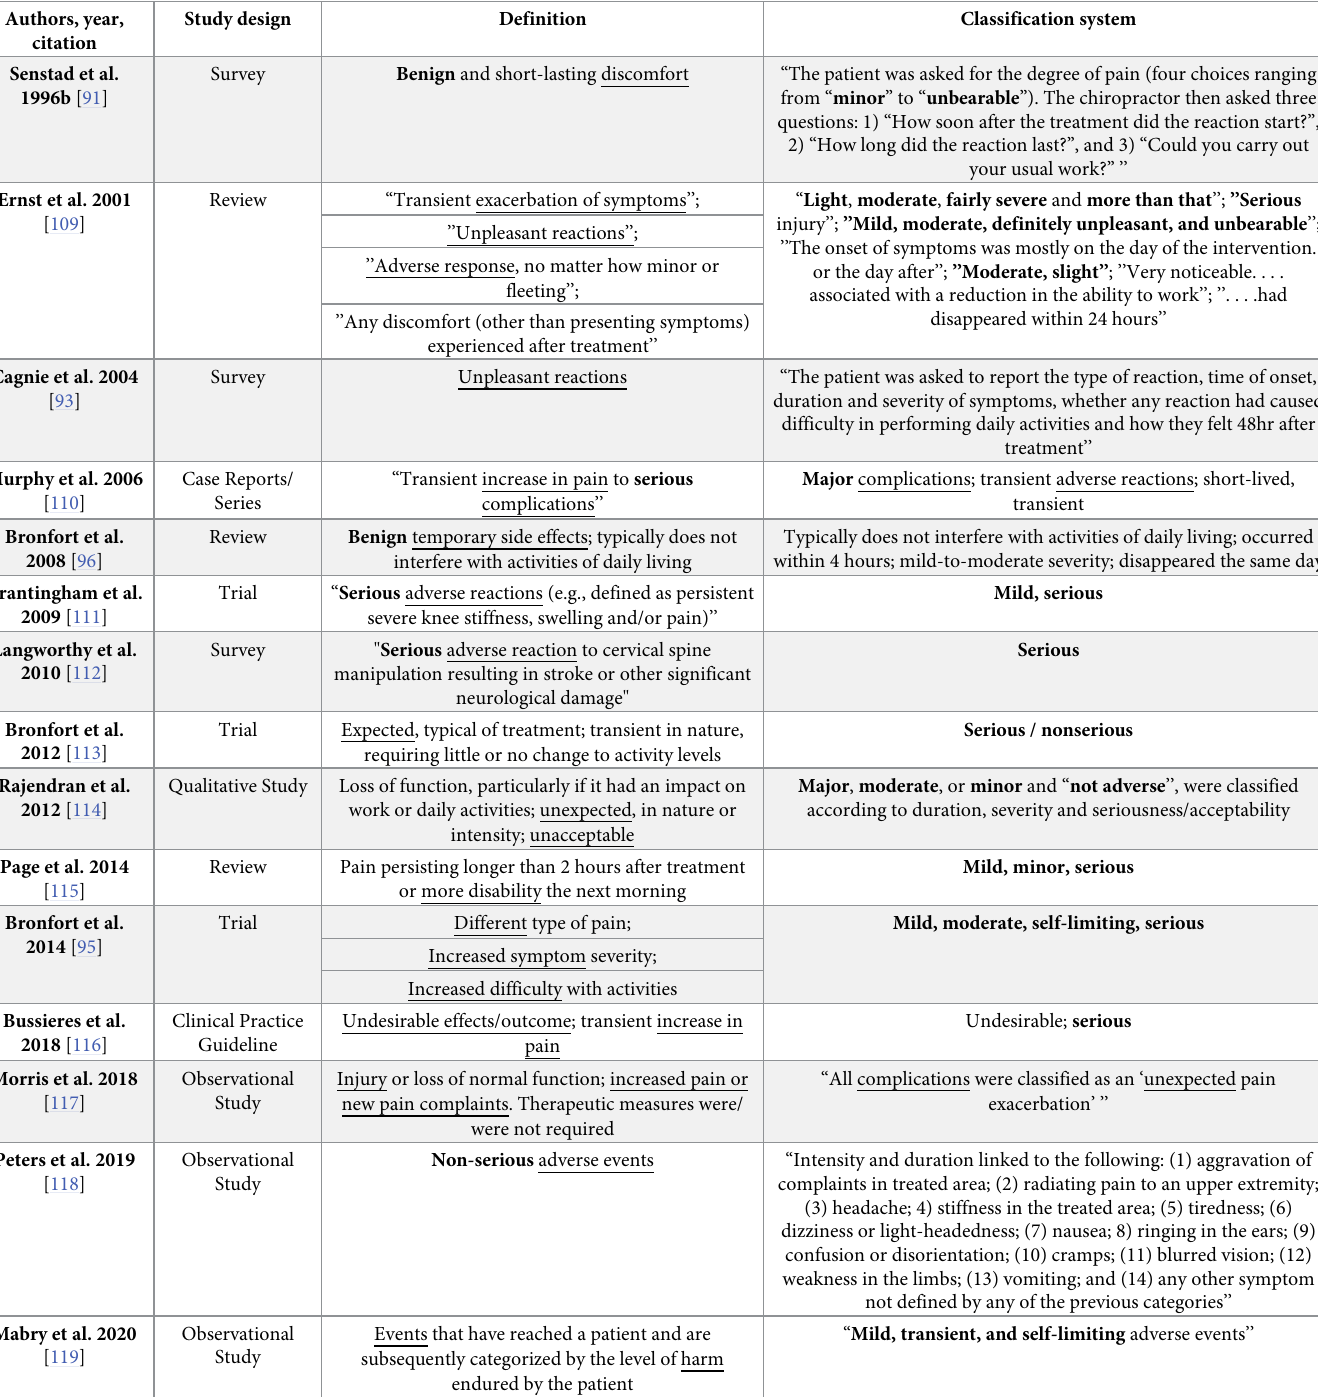
Table 8. Studies providing indirect adverse event definition & classification system (n =